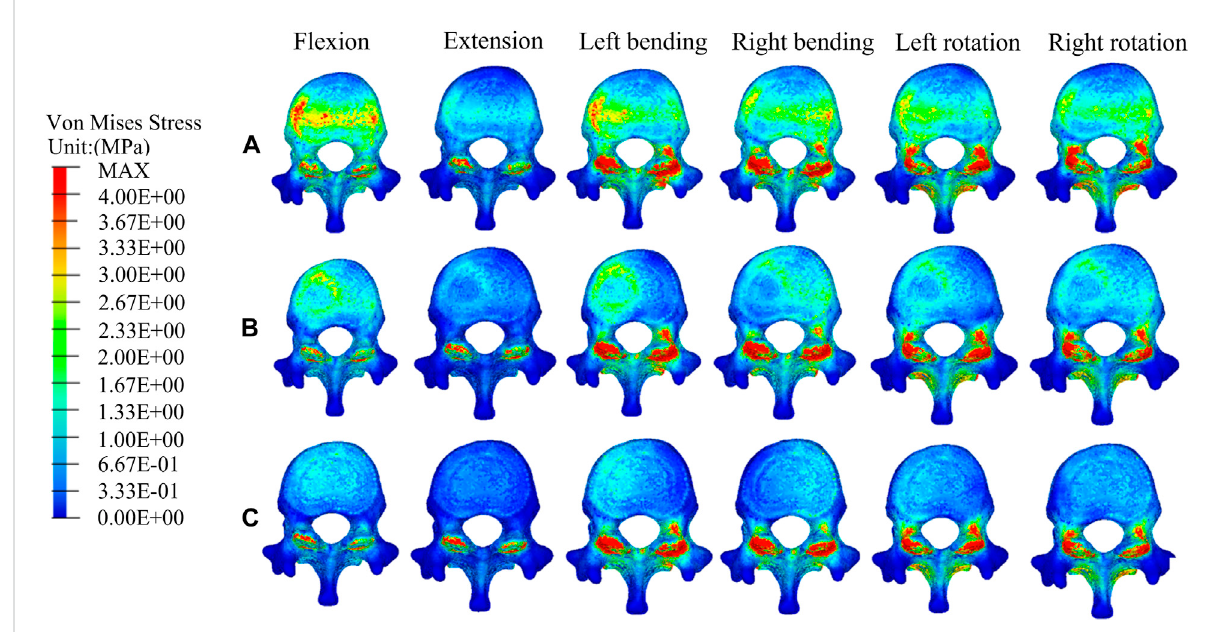
FIGURE 5 ThedistributionsofthevonMisesstressonT12.ThedistributionsofthevonMisesstressonT12inafracturedmodel (A) ,UPVP (B) ,andBPVP (C) under fl exion, extension, left/right bending, and left/right